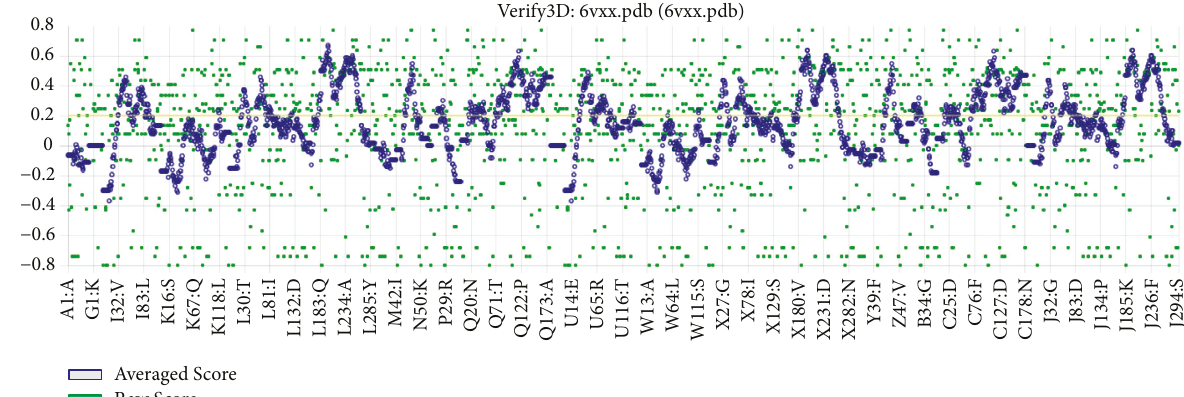
Figure 6: Evaluation of protein model of SARS-CoV-2-SG by